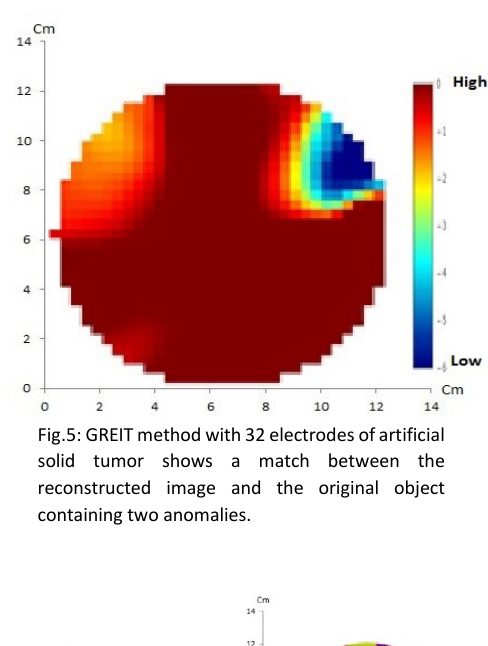
Fig.4: GREIT method with 16 electrodes of artificial solid tumor shows discordance between the reconstructed image and the original object in which only one anomaly is displayed instead of two.